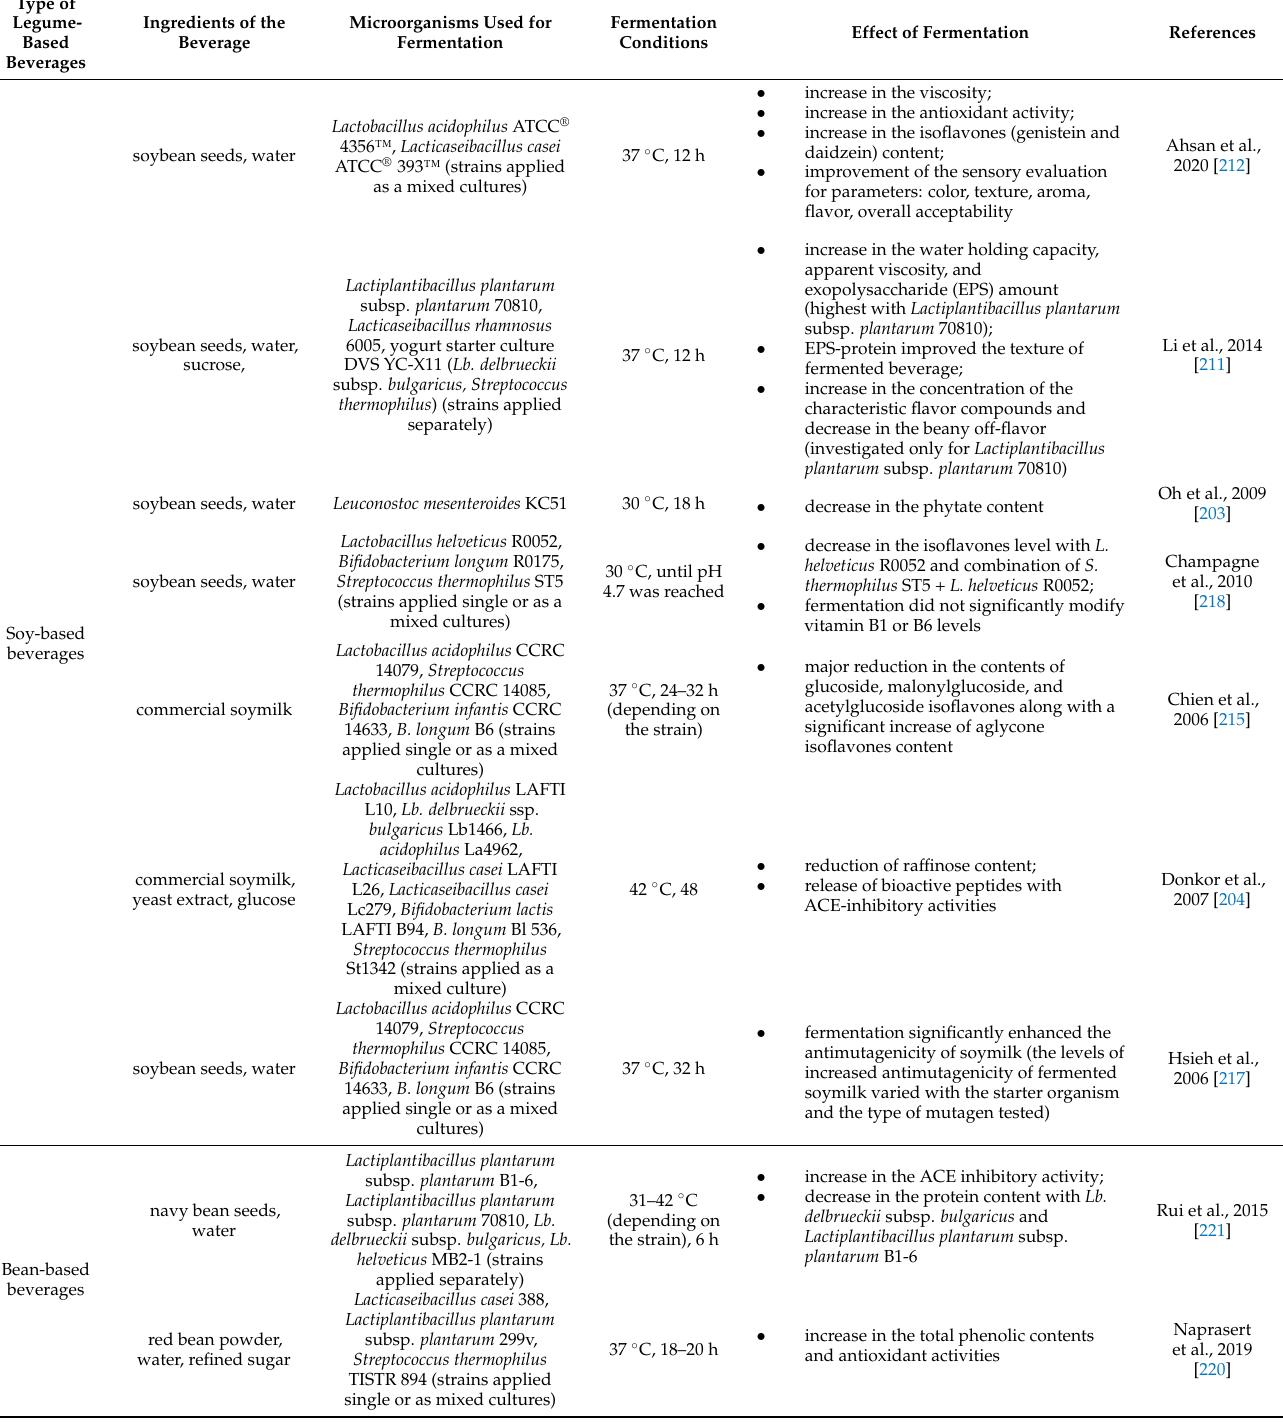
Table 6. Effect of fermentation with LAB on selected properties of legume-based